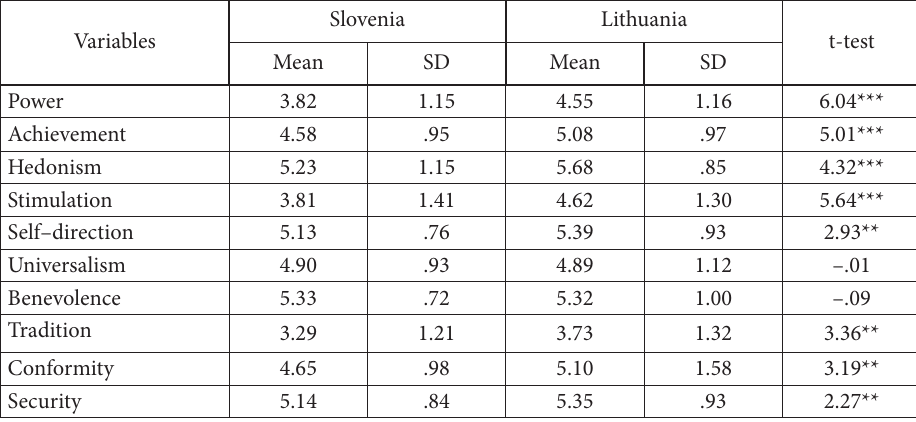
Table 4. Personal values of future employees in Slovenia and Lithuania (created by the authors)